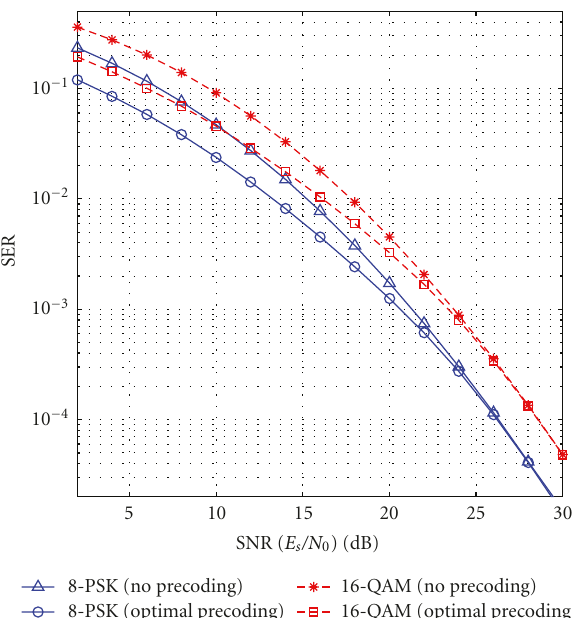
Figure 5: Performance improvements achieved with optimal precoding in a 4 × 2 MIMO system based on OSTBC C 4 from [20] and the exponential channel correlation model.